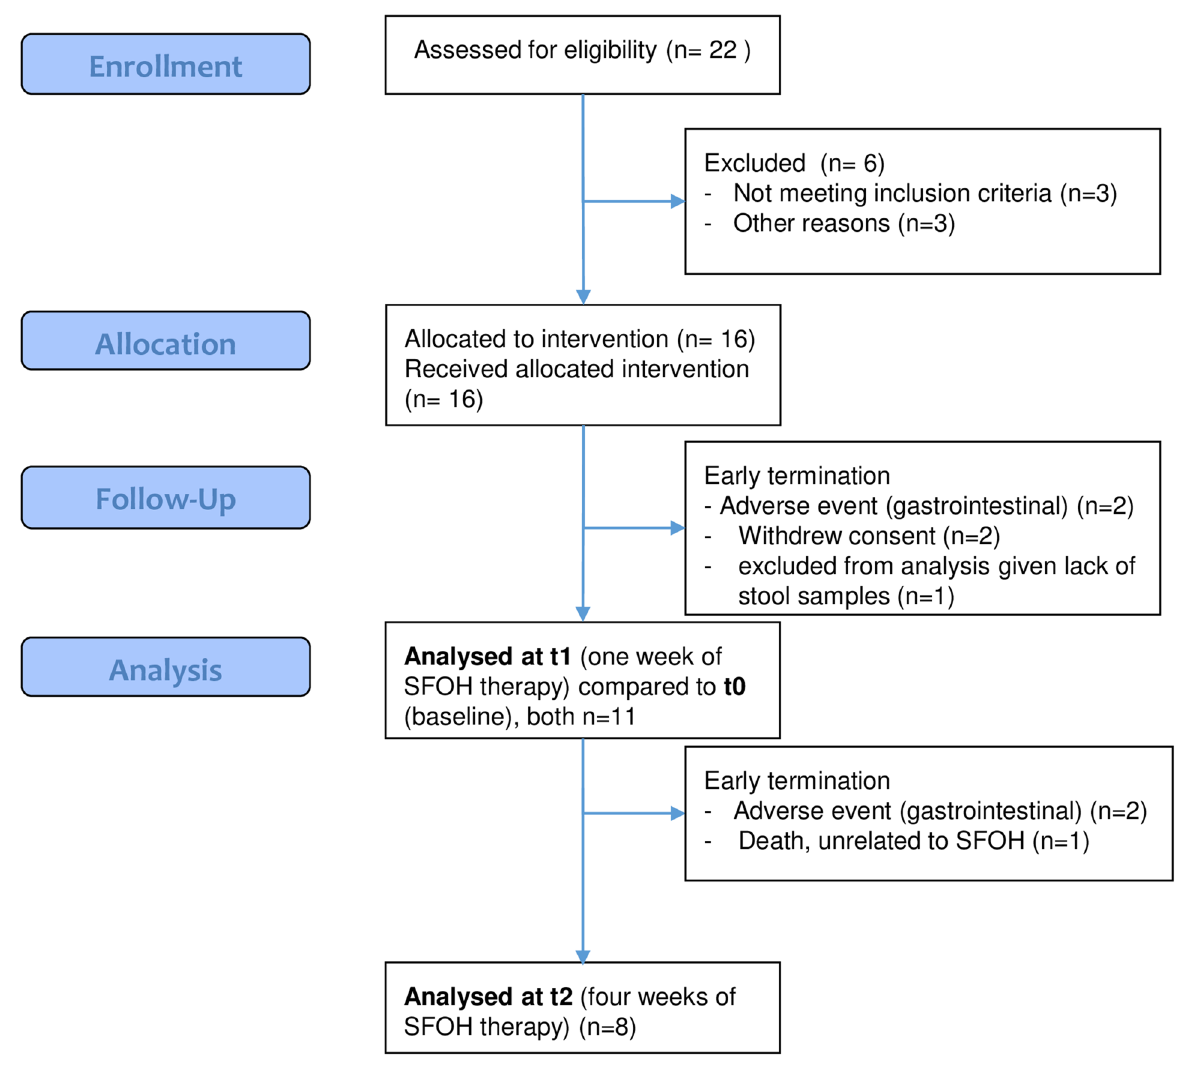
Figure 1. CONSORT flow diagram of the